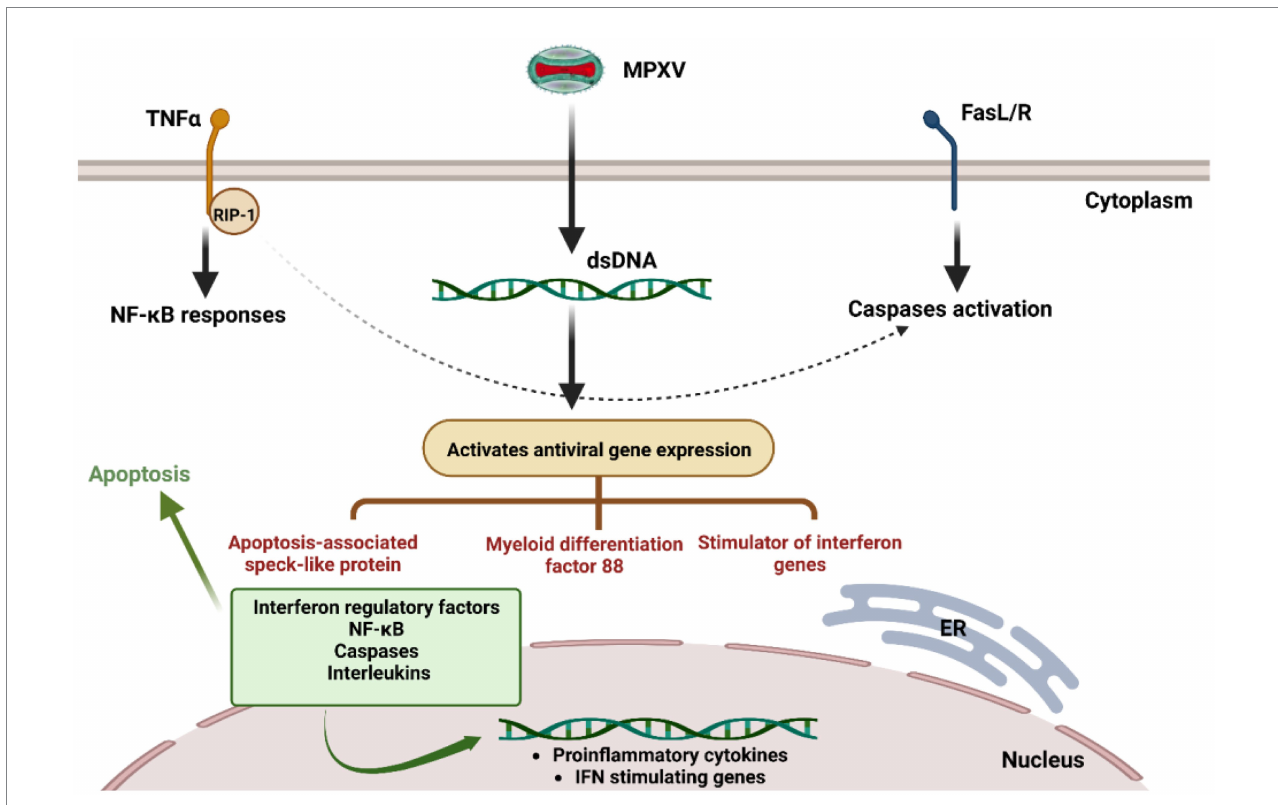
FIGURE 1 Suggested monkeypox virus immune evasions. During infection, the MPXV can escape from a series of downstream and upstream elements that cause the production of interferons, cytokines, and interleukins for the antiviral immune